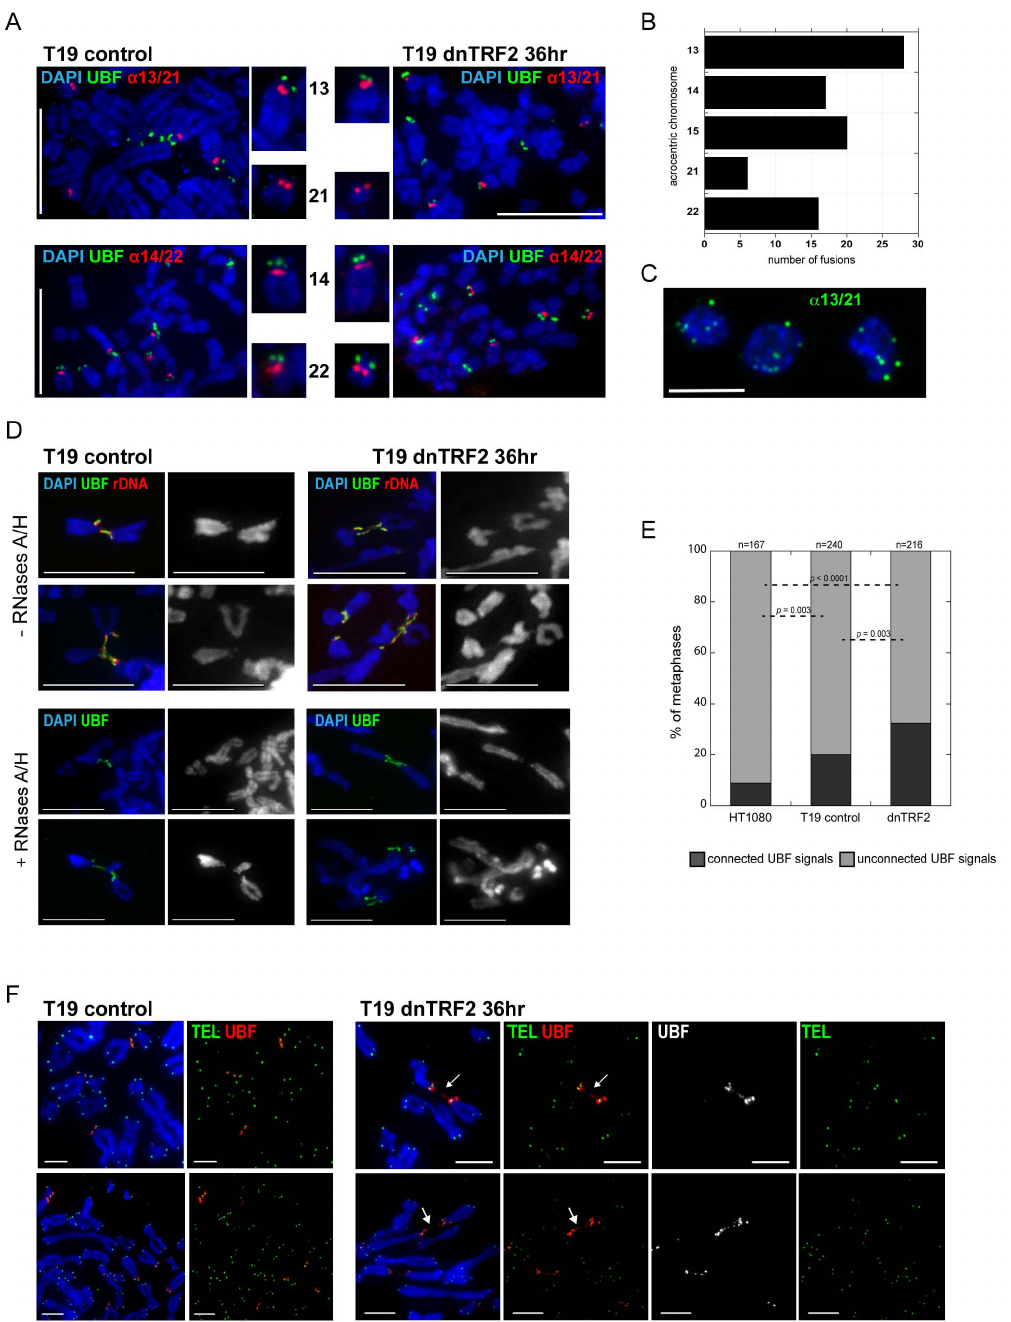
Figure 7. Connections between certain acrocentric short arms during metaphase. (A) Immunostaining-FISH on metaphase chromosomes from T19 control (dnTRF2 uninduced) and T19 dnTRF2 induced (36 hours) cells for UBF (green) and acrocentric alpha satellite DNA (red, alpha satellite 13/21 or alpha satellite 14/22) shows absence of UBF on HSA21. UBF was associated with the short arms of HSA13, HSA14, and HSA22. Scale bars equal 15 micrometers. (B) It was notable that HSA21 did not show UBF immunostaining since this chromosome was involved in the least number of acrocentric fusions when dnTRF2 was transiently expressed for 36 hours. (C) The T19 cells contained an average of 4 copies of HSA13 and 3 copies of HSA21. Isolated nucleoli were hybridized with a FISH probe (green) recognizing the identical alpha satellite sequence that defines the centromeres of HSA13 and HSA21. Nucleoli had an average of 7 FISH signals, suggesting that all copies of HSA13 and HSA21 within the cells were associated with nucleoli. (D) Immunostaining-FISH on metaphase chromosomes revealed the presence and increased persistence of UBF (green) and rDNA (red) within the connections/bridges between acrocentric short arms in dnTRF2-expressing cells. Scale bars equal 15 micrometers. (E) Quantitation of acrocentric bridges/associations. HT1080 control and T19 uninduced control showed fewer UBF mediated acrocentric associations compared to dnTRF2 induced (36 hour) cells. Numbers at the top of each bar represent the total number of metaphases analyzed. Statistical significance ( p values less than 0.05) was determined by a Chi square test for a 2 6 2 contingency table. (F) Immunostaining for UBF (red) and FISH with a PNA-TEL probe (Green) demonstrated that connections between acrocentrics in dnTRF-expressing cells did not include telomeric DNA.